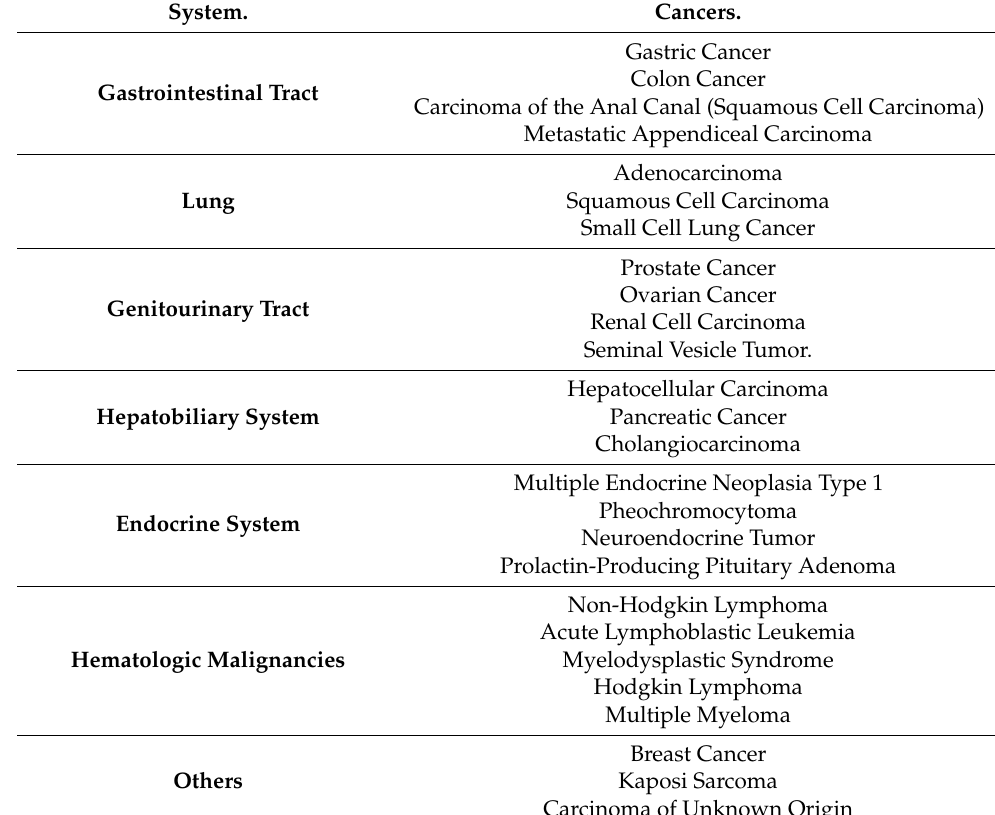
Table 1. Cancers associated with TMA [44–49].